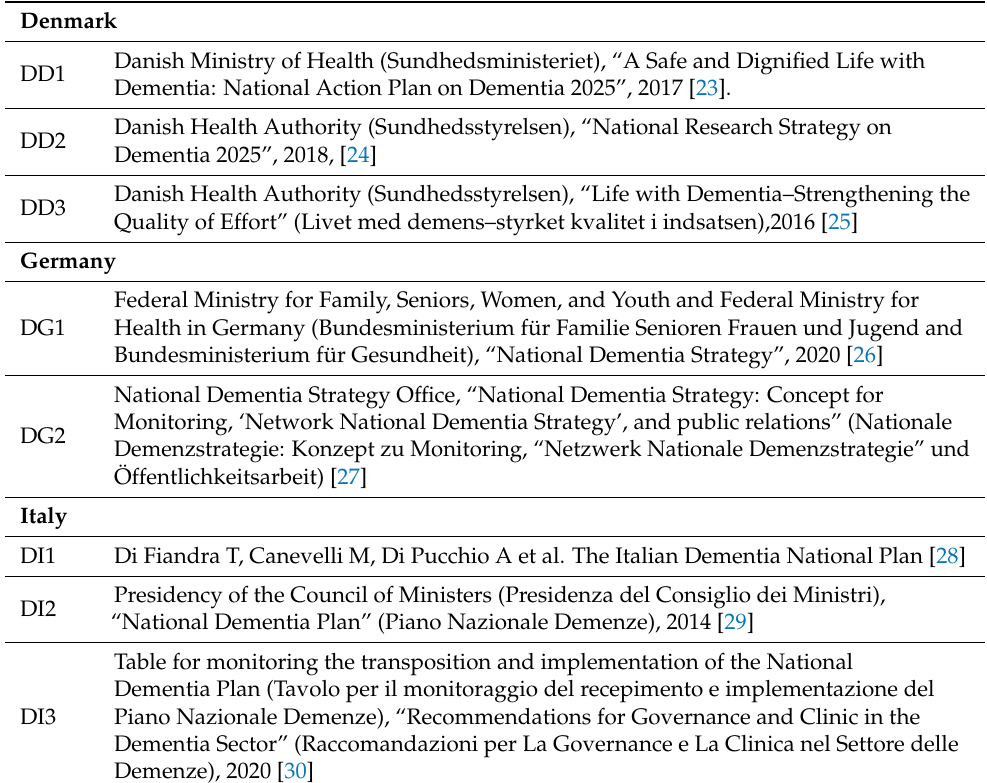
Table for monitoring the transposition and implementation of the National Dementia Plan (Tavolo per il monitoraggio del recepimento e implementazione del Piano Nazionale Demenze), “Recommendations for Governance and Clinic in